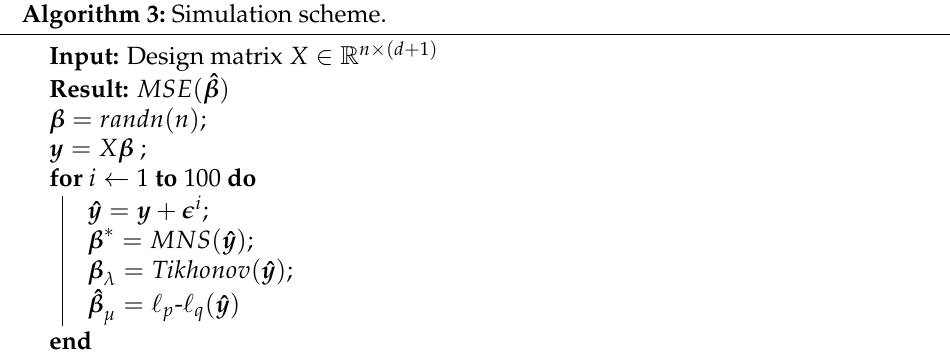
Algorithm 3: Simulation scheme.